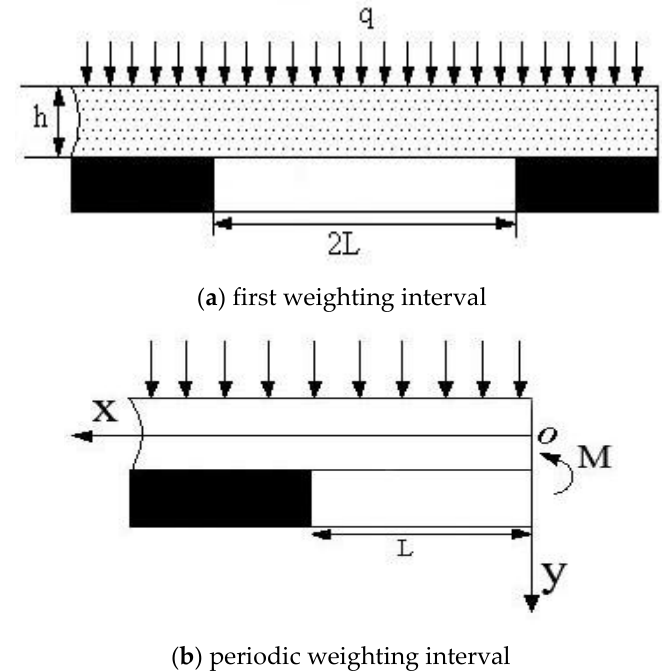
Figure 3. Mechanical analysis model of the rock beam of the basic roof.